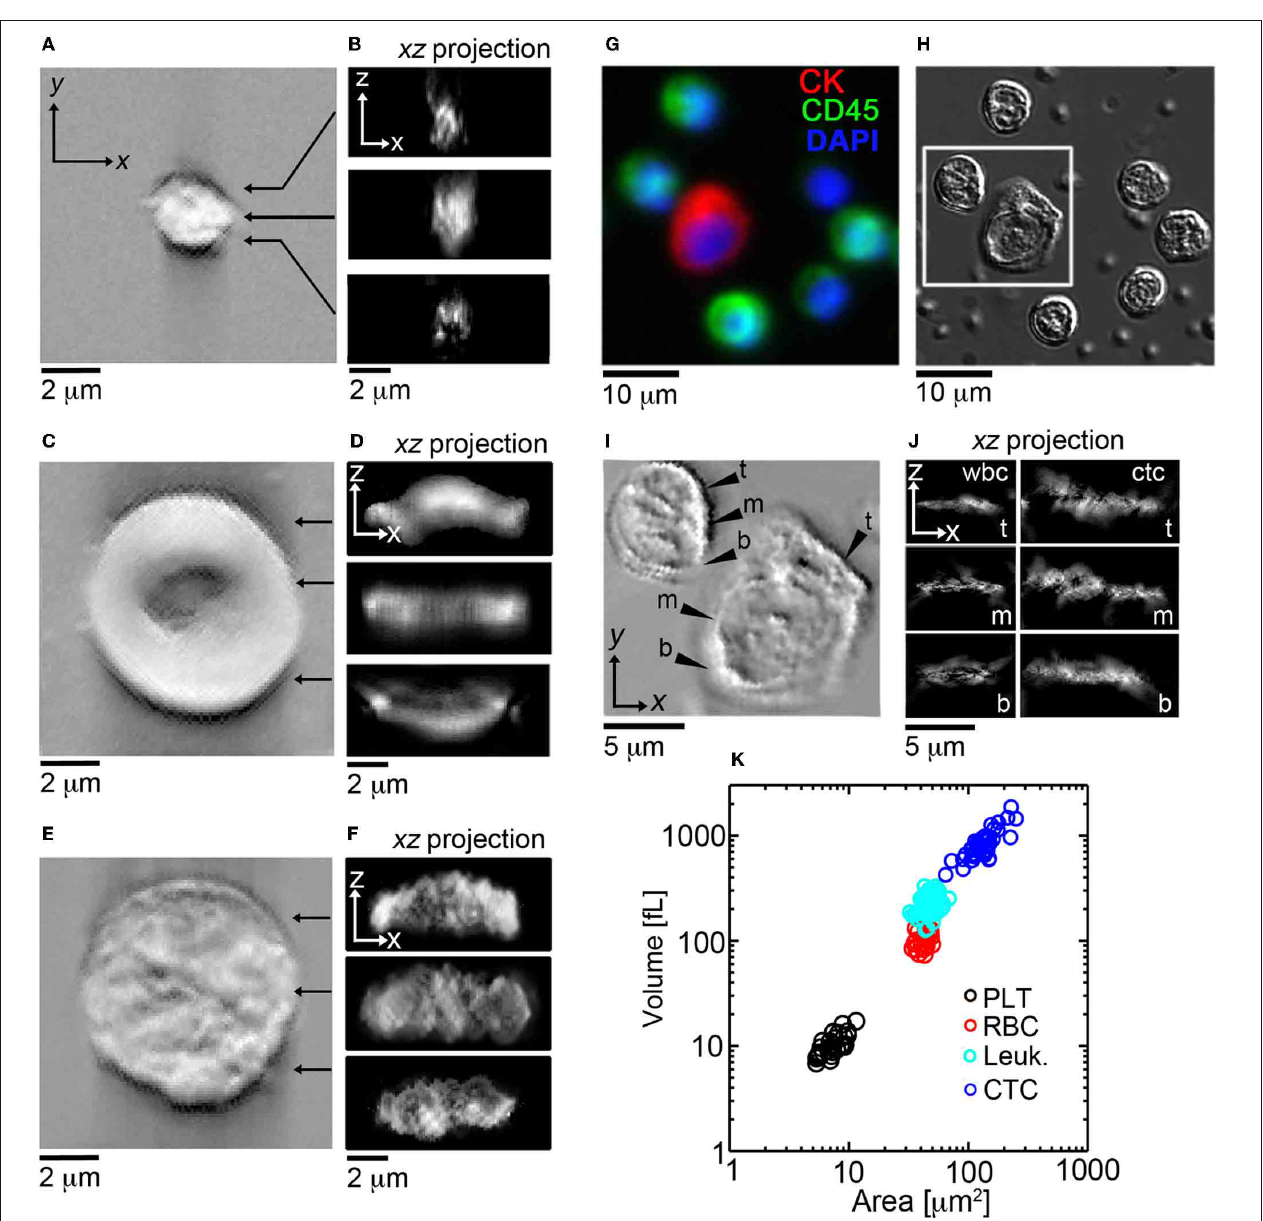
from breast cancer patient, (H) corresponding DIC image, (I) corresponding Hilbert transformed DIC image, (J) corresponding cross sectional images at the t, top; m, middle; b, bottom locations denoted in (I) . (K) Scatter plot of cell areas vs. corresponding volume for each cell type.